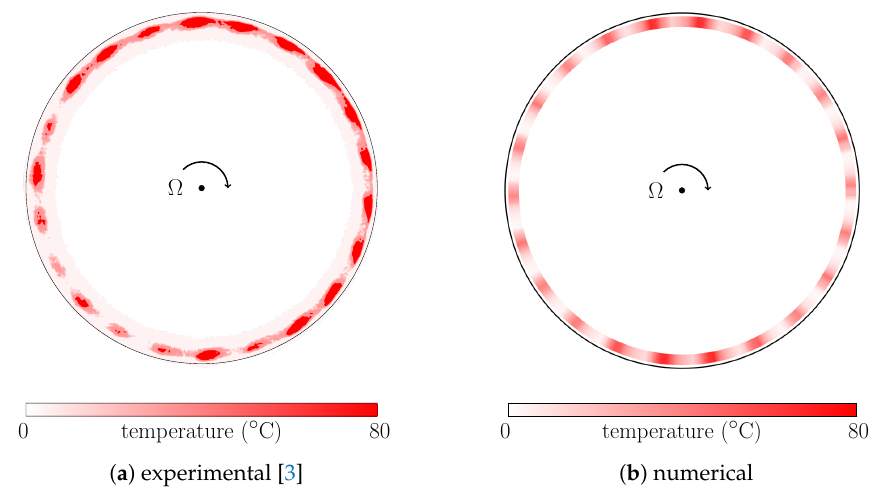
Figure 11. Temperature profile for the HP compressor test case.